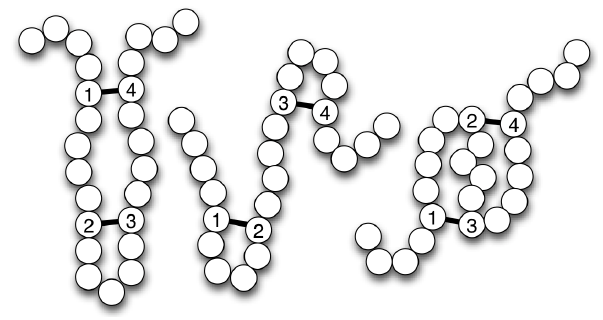
Figure 2. Example of disulfide patterns. A protein with two disulfide bridges and its three possible disulfide connectivity patterns.